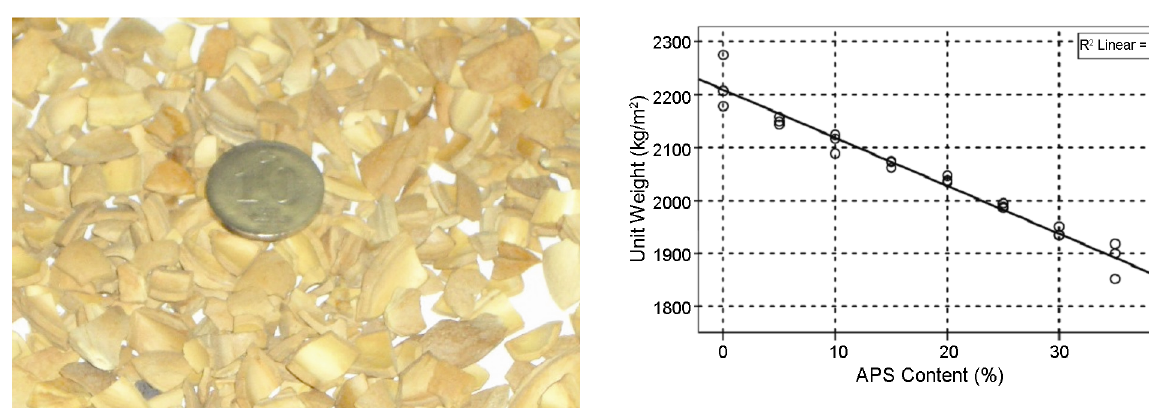
Table 2. Experimental results of concrete including APS